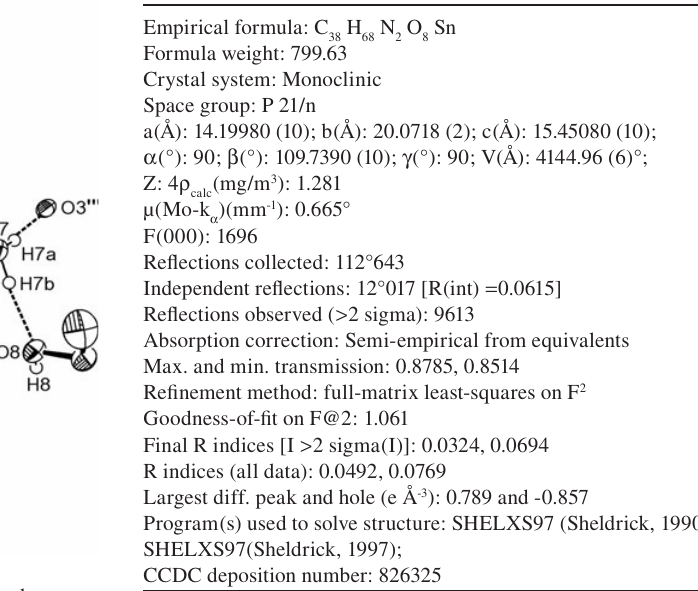
Table 1 Crystal data and structure refi